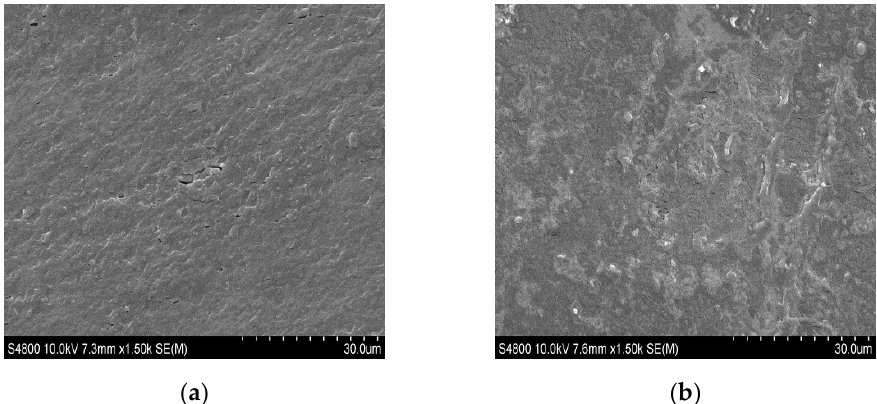
Figure 6. SEM images of ( a ) the cross-section and ( b ) the surface of SPI films at × 1.50 magnification.